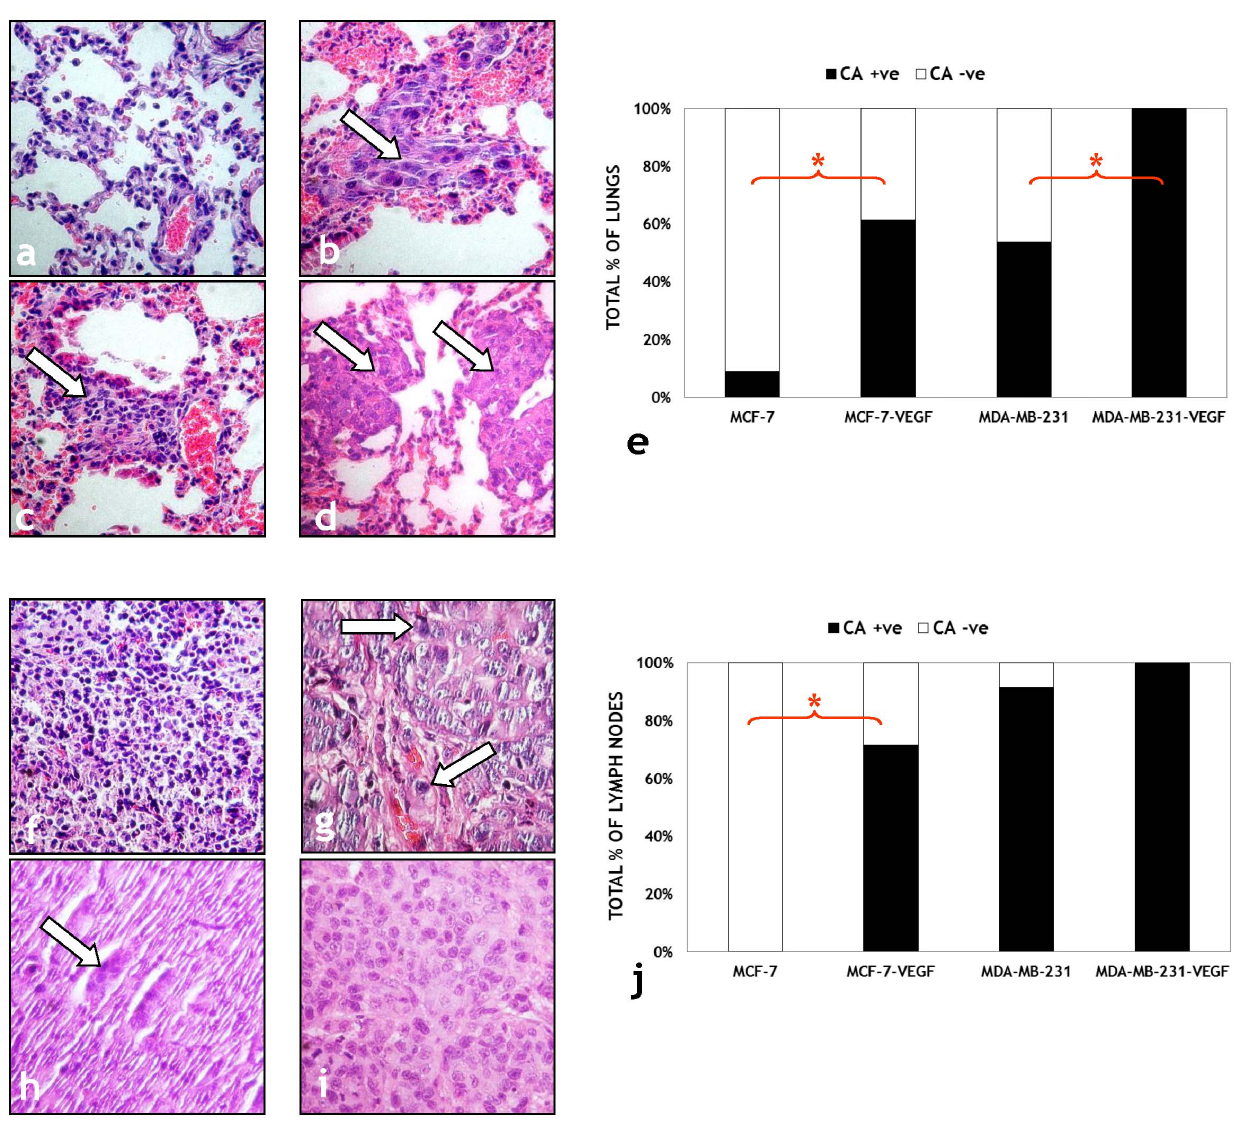
Figure 7. Histological validation of the transformation of non-invasive MCF-7 tumors to the metastatic phenotype following VEGF overexpression. Representative (40 6 ) images of H&E stained lung sections from: (a) MCF-7, (b) MCF-7-VEGF, (c) MDA-MB-231 and (d) MDA-MB-231- VEGF tumor bearing animals. Cancer cells are indicated by solid arrows in each panel. (e) Comparison of the number of animals with cancer positive (CA + ve ) and cancer negative (CA -ve ) lungs for each type of breast cancer xenograft. Representative (40 6 ) images of H&E stained lymph node sections from: (f) MCF-7, (g) MCF-7-VEGF, (h) MDA-MB-231 and (i) MDA-MB-231-VEGF tumor bearing animals. Cancer cells are indicated by solid arrows in each panel. (j) Comparison of the number of animals with cancer positive (CA + ve ) and cancer negative (CA -ve ) lymph nodes for each type of breast cancer xenograft.